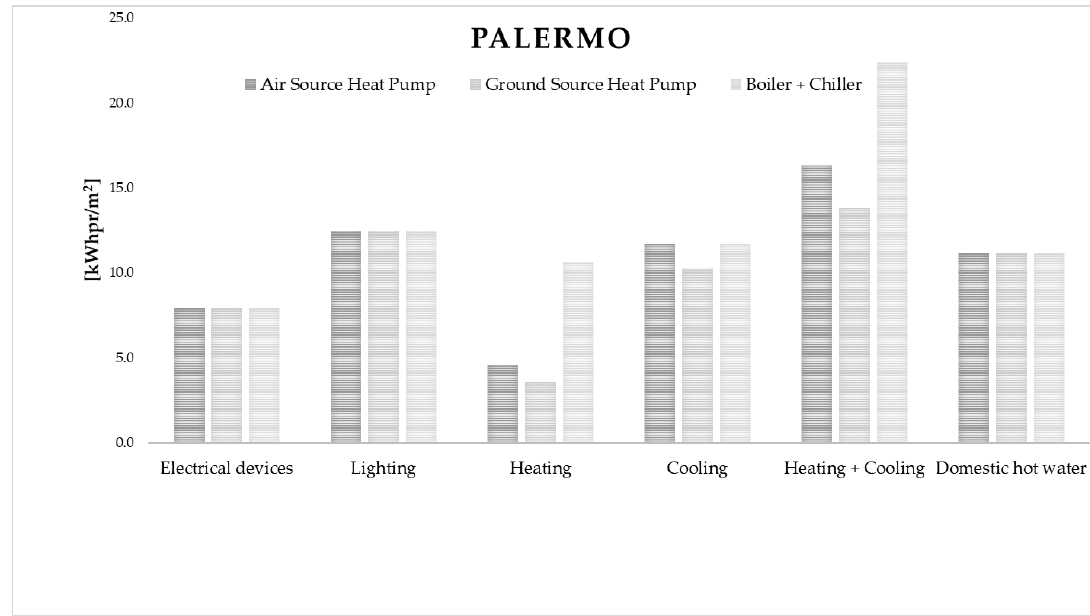
Figure 4. Primary energy demand (kWh/m 2 y) for the three different proposed systems in the case of Palermo. Energies 2020 , 13 , x FOR PEER REVIEW 11 of 22